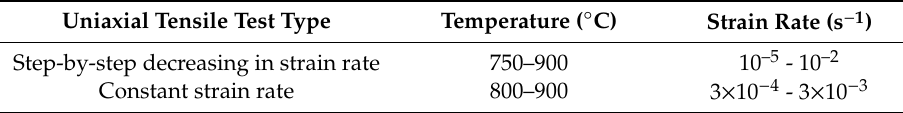
Table 1. Temperature and strain rate ranges of the uniaxial tensile